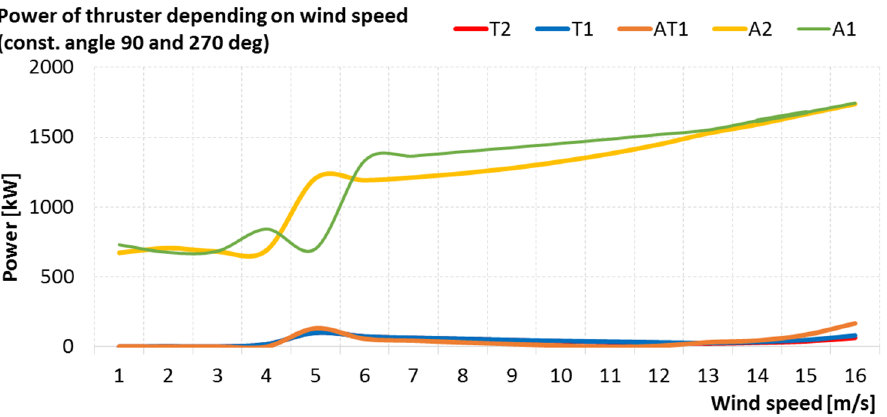
Figure 8. The power of individual thrusters depending on the wind speed (90 and 270 deg.).